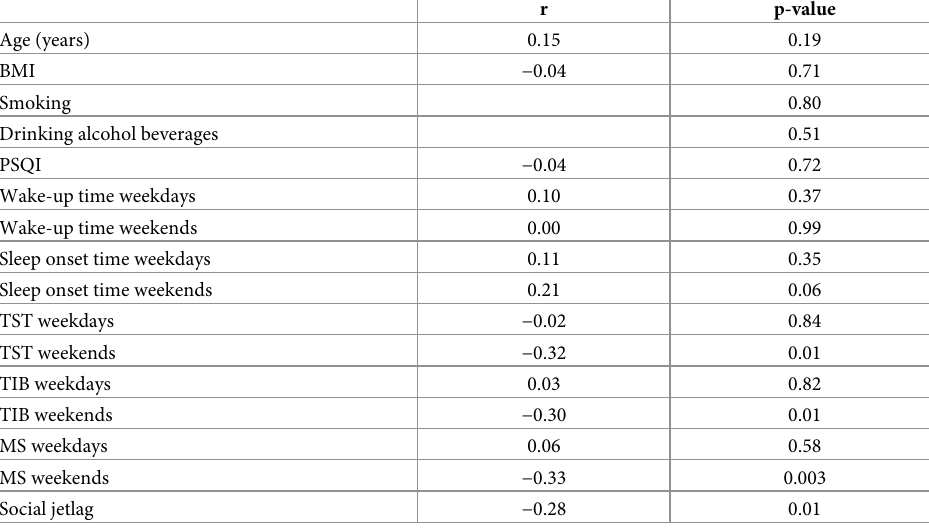
Table 3. Serum BDNF levels correlate with the sleep pattern on